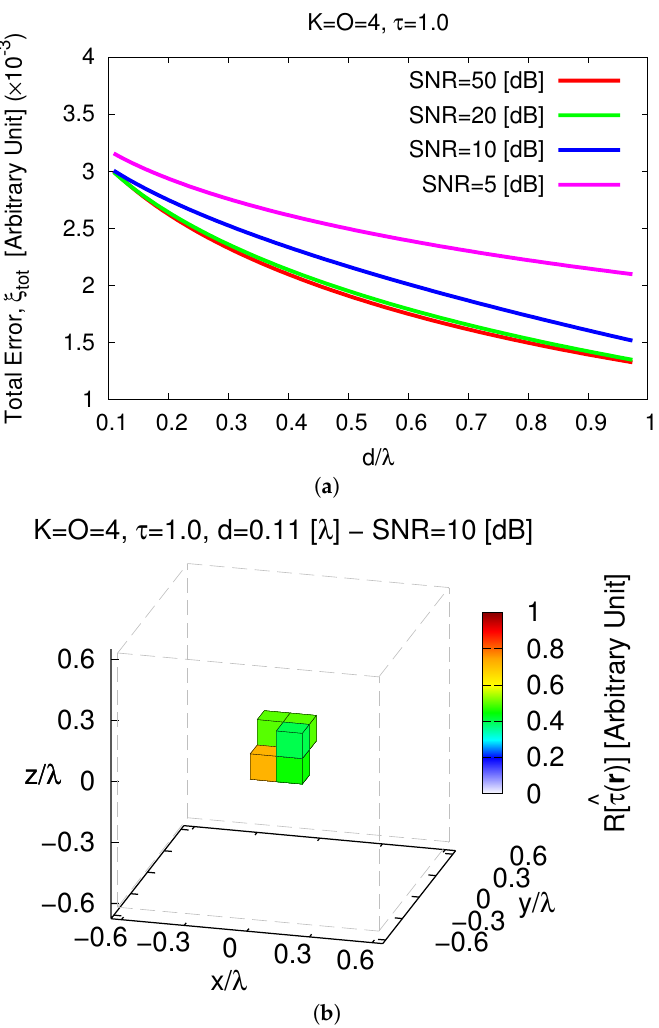
Figure 12. Numerical Assessment ( K = 4, O = 4, τ = 1.0, SNR ∈ [ 5, 50 ] [dB])—( a ) Behavior of the total error, ξ tot , as a function of the objects distance from the origin, d and ( b ) filtered ( τ th = 10 − 3 ) MT-BCS reconstruction when the objects distance from the origin is d = d min = 0.11 [ λ ] ( (cid:98) τ max =